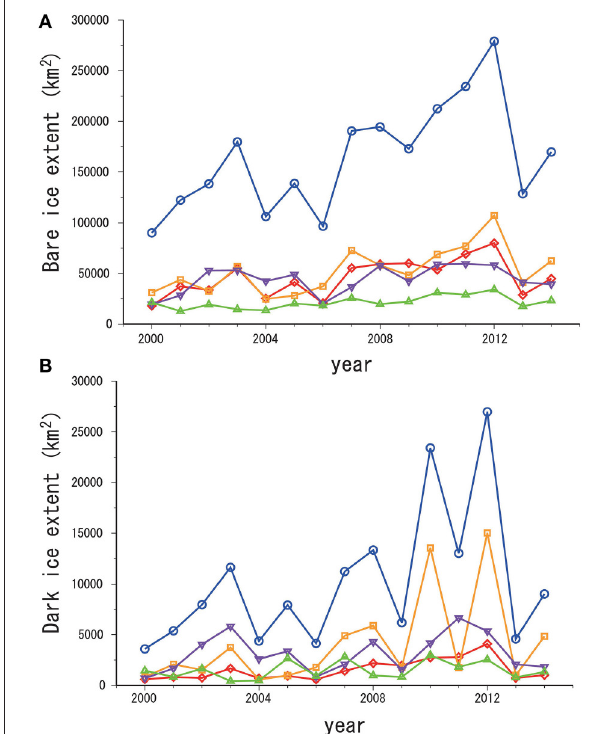
FIGURE 4 | Annual variability of bare ice (A) and dark ice (B) extents in the whole region (blue circle) and northwestern (red diamond), northeastern (purple inverted triangle), southwestern (orange square), and southeastern (green triangle) regions from 2000 to